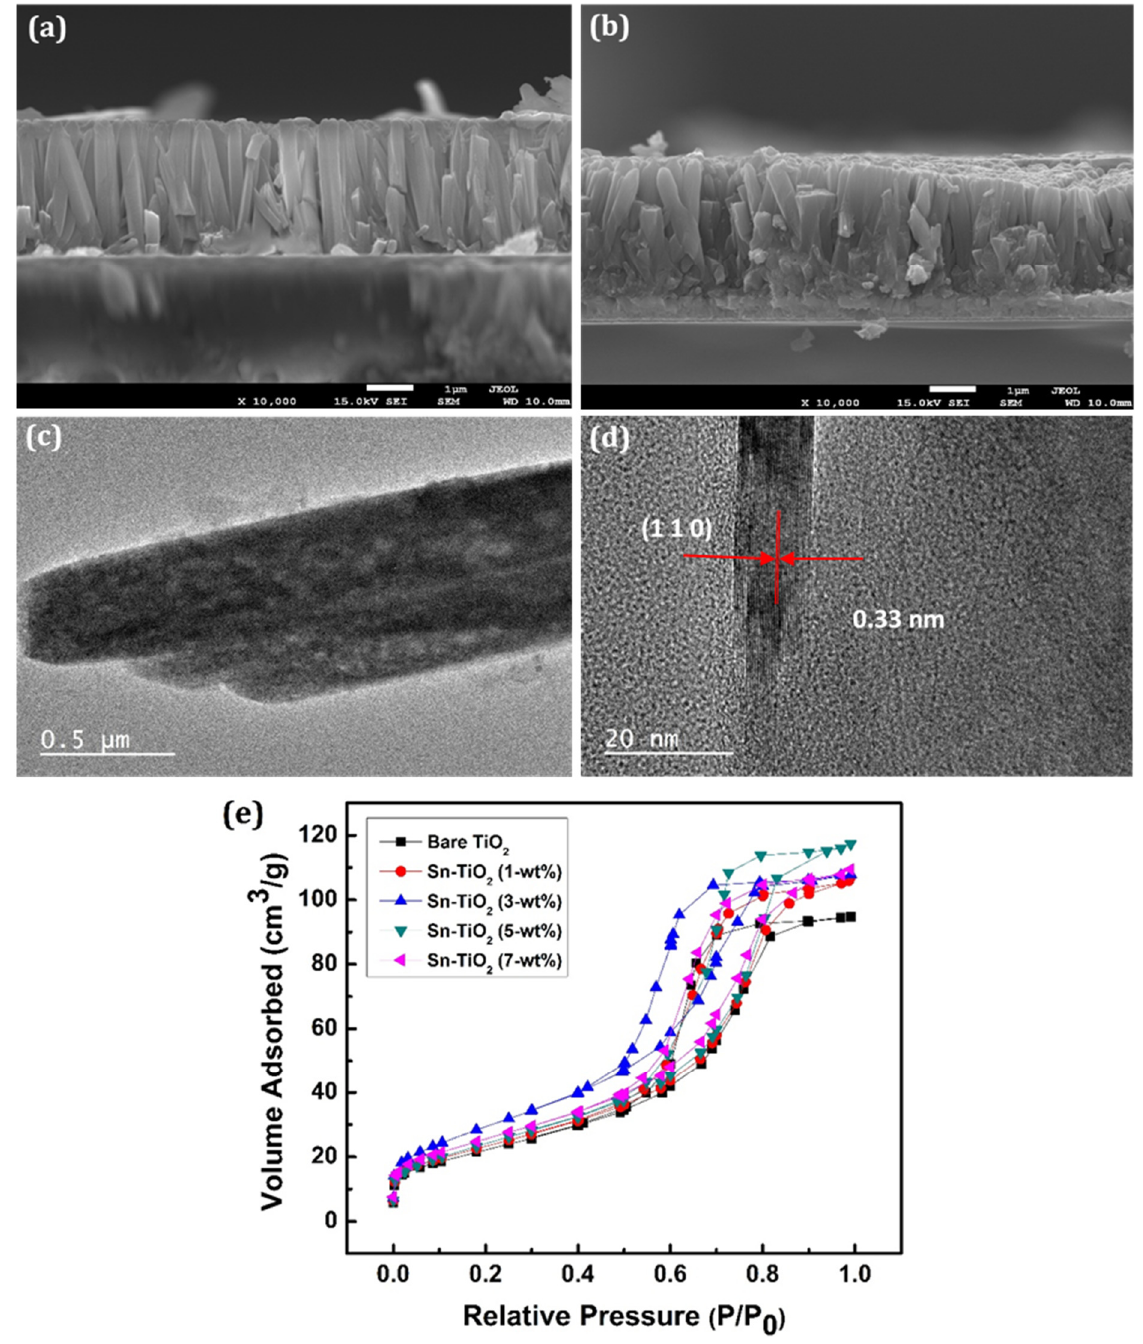
Figure 3. SEM cross-section of ( a ) 3-wt % ( b ) 7-wt % Sn-TiO 2 thin films. HR-TEM image of 7-wt % Sn-TiO 2 ( c ) Bundles of nanorods and ( d ) Lattice fringes with interplanar spacing of (110) reflection. ( e ) The N 2 adsorption-desorption isotherms of the bare TiO 2 and Sn-TiO 2 thin films with varying Sn concentration .